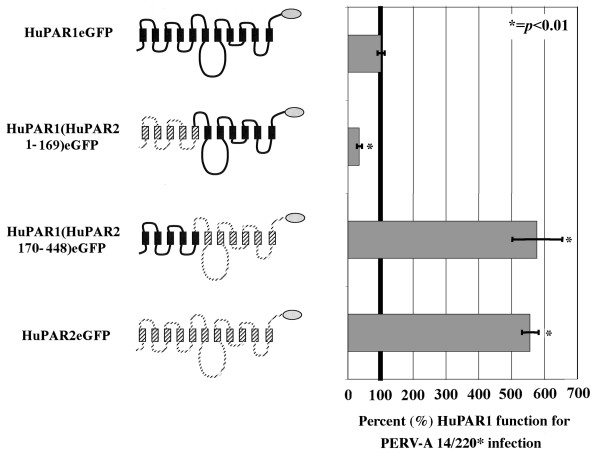
HuPAR1 and HuPAR2 chimeras reveal that the C-terminal two-thirds of HuPAR2 is responsible for the increased functionality compared to HuPAR1. eGFP-tagged chimeras (gray oval) were constructed between HuPAR1 (solid black) and HuPAR2 (dashed black). PERV-A 14/220* infection levels were determined for SIRC cells stably expressing each of the chimeric constructs. For purposes of comparison, we arbitrarily set the function of HuPAR1eGFP to 100%. The results indicate that HuPAR2 residues 170–448 contain the sequences responsible for the increased function for PERV-A infection.